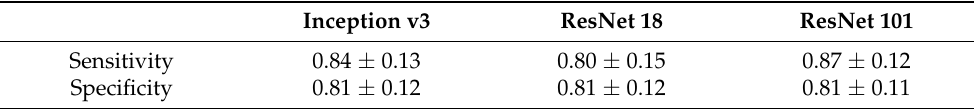
Table 2. Metastasis classification results for the pelvis